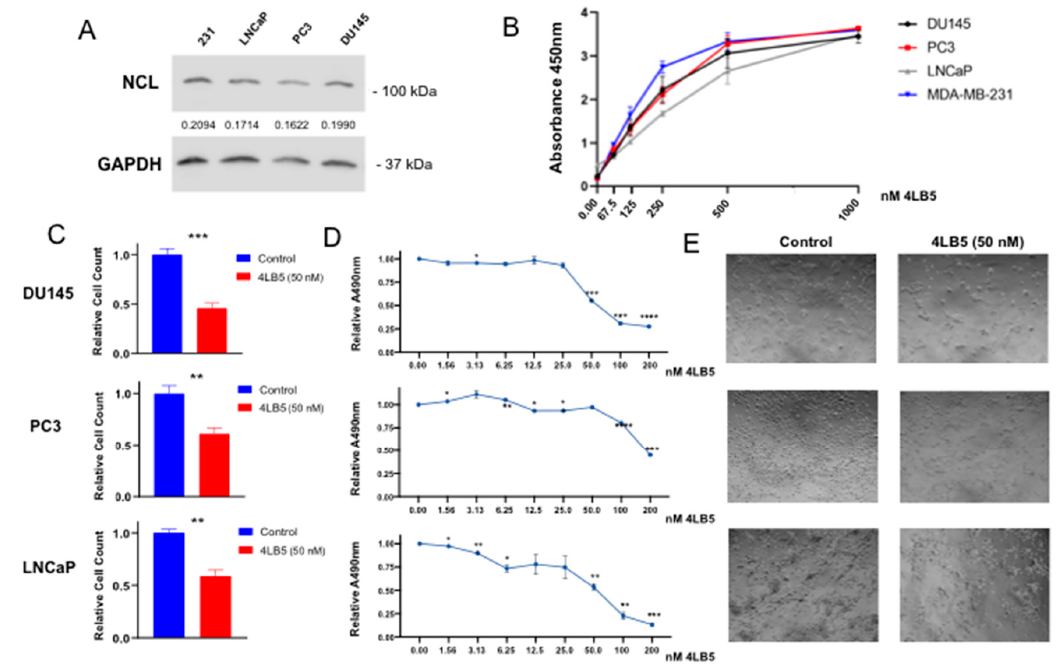
Figure 2. 4LB5 Binds to PCa Cells and Inhibits Cell Proliferation ( A ) Basal expression levels of whole-cell NCL protein was measured in LNCaP, PC3, and DU145 PCa cell lines and compared to MDA-MB-231 expression levels via Western blot. Uncropped blots of Figure 2A are shown in Figure S4. ( B ) 4LB5 binding cell surfaces was assessed by an ELISA performed after incubating cells with serial dilutions of 4LB5. ELISA data shown are representative of two independent experiments performed in quadruplicate. ( C ) Relative cell counts of DU145, PC3, and LNCaP cells treated with 50 nM 4LB5 or control solution for 48 h. Cell survival data are the average of five biological replicates. ( D ) MTS assay performed after 72 h-treatment with increasing concentrations of 4LB5. MTS data are average of two assays performed in biological triplicate. ( E ) Light microscopy images of PCa cells taken at 48 h post-treatment with 50 nM 4LB5 or control solution. * p < 0.05, ** p < 0.01, *** p < 0.001, **** p < 0.0001.